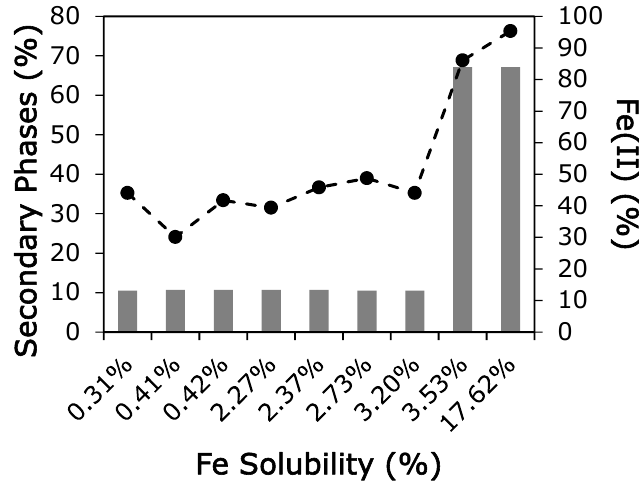
Figure 5. In samples from the GEOTRACES collection, the fractional solubility of iron was higher when more Fe(II) (black line) was present or when more secondary phases (grey bars) were present. Secondary phases include Fe(II and III) sulfates and iron phosphates; these compounds are collectively labeled as secondary phases because these are phases that may form through secondary reactions that occur in the atmosphere. However, such secondary phases may also be initially present in aerosols derived from coal fly ash or volcanic materials.